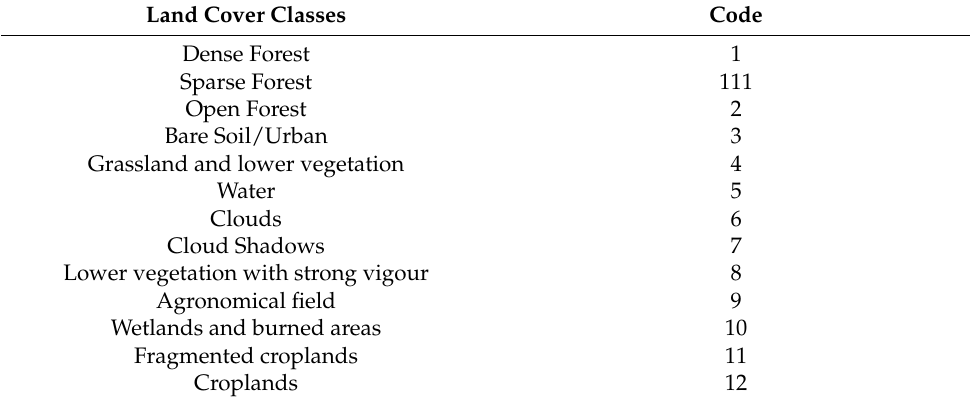
Table 4. Land cover codes.